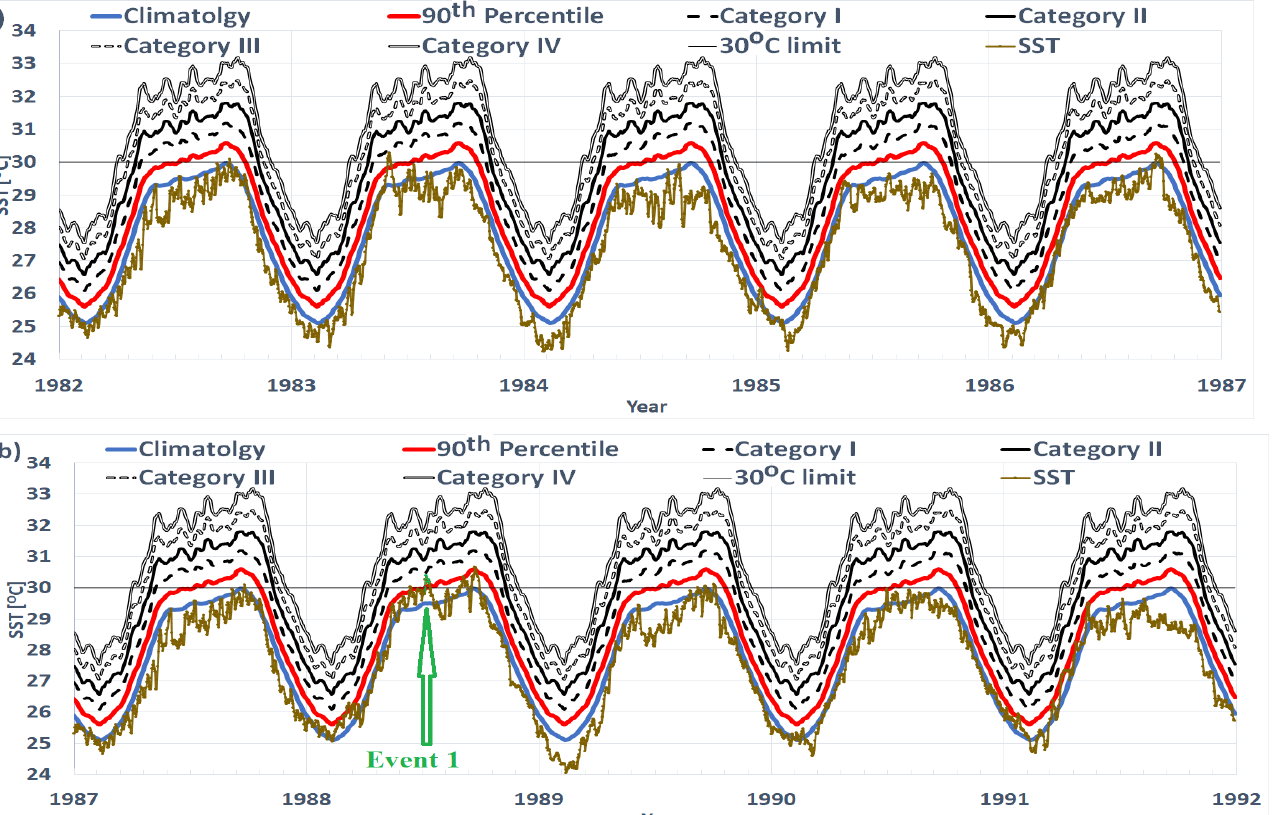
Figure 3. Spatial distribution of the threshold ( a ) and magnitude ( b ) of warm SST ETEs (90th percentile) over Red+.